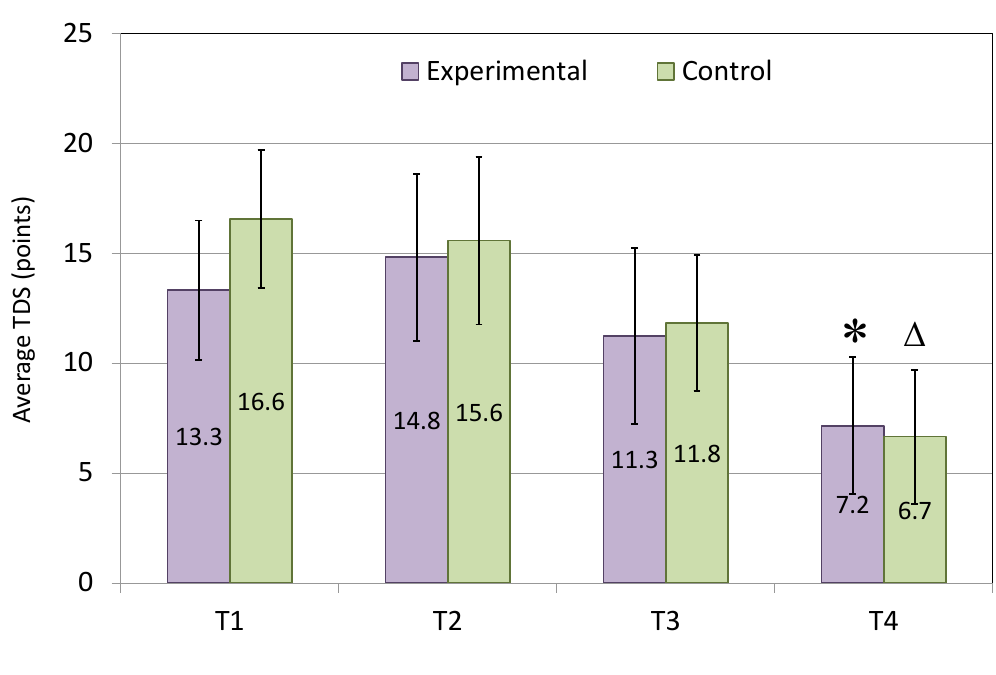
Figure 4. Training distress scores (TDS) of the swimmers from the experimental (n=12) and the control (n=12) groups on the 1 st (T1), 14 th (T2), 28 th (T3) and 42 nd (T4) days of the six-week training period. * - p < 0.05 vs Experimental T2; Δ - p < 0.05 vs Control T1 and Control T2